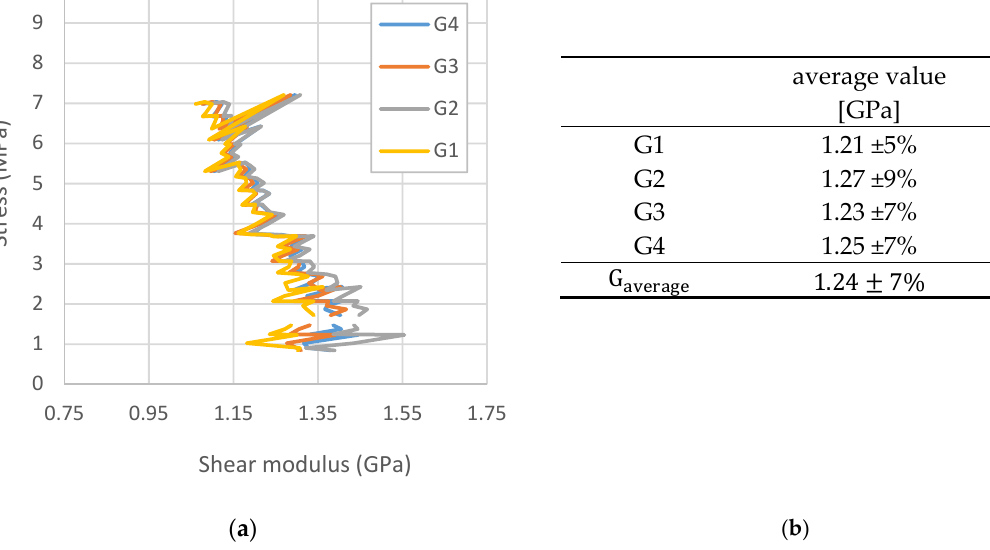
Figure 9. Determination of the average value of the shear modulus.